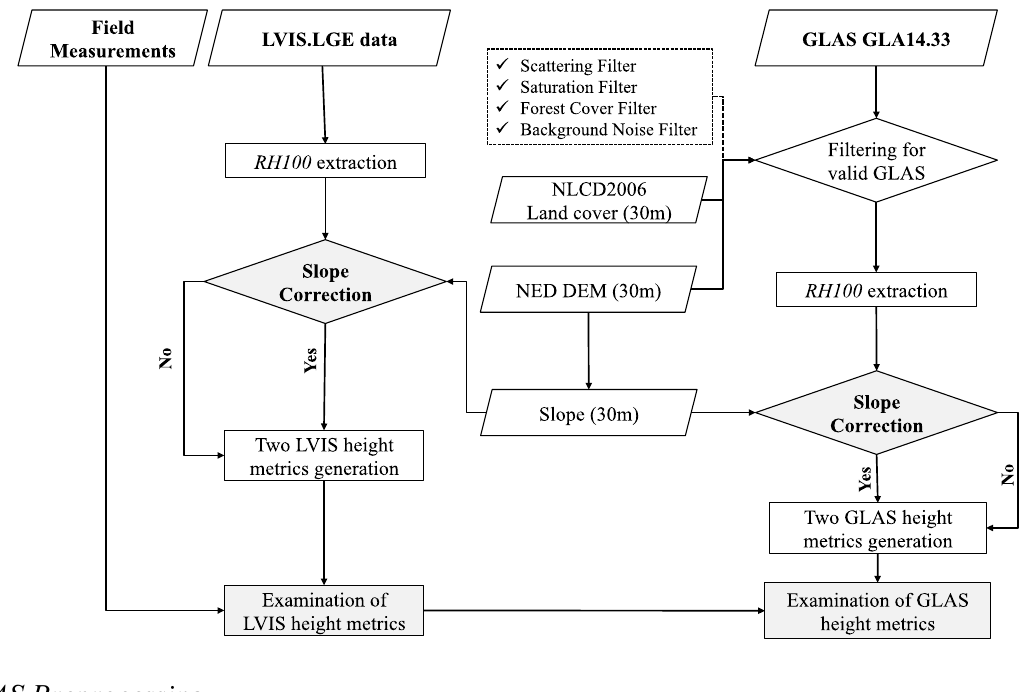
Figure 2. Overall scheme of physically-based slope corrections for LVIS and GLAS maximum forest canopy height